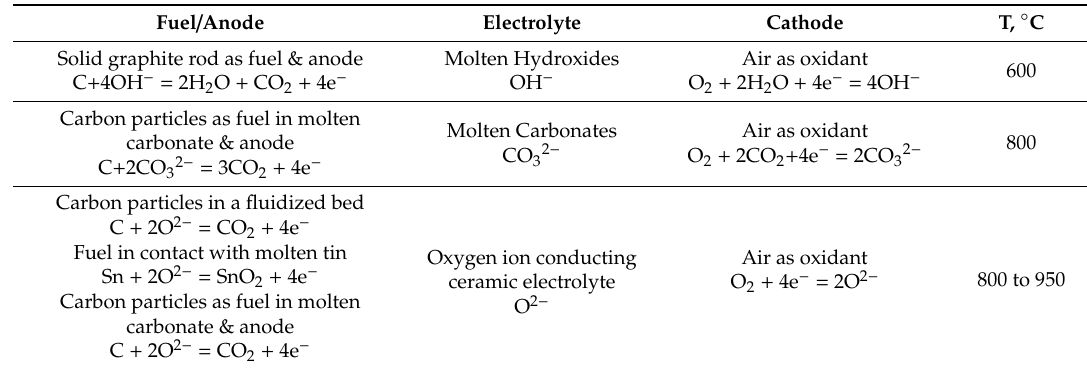
Table 1. Types of direct carbon fuel cells.